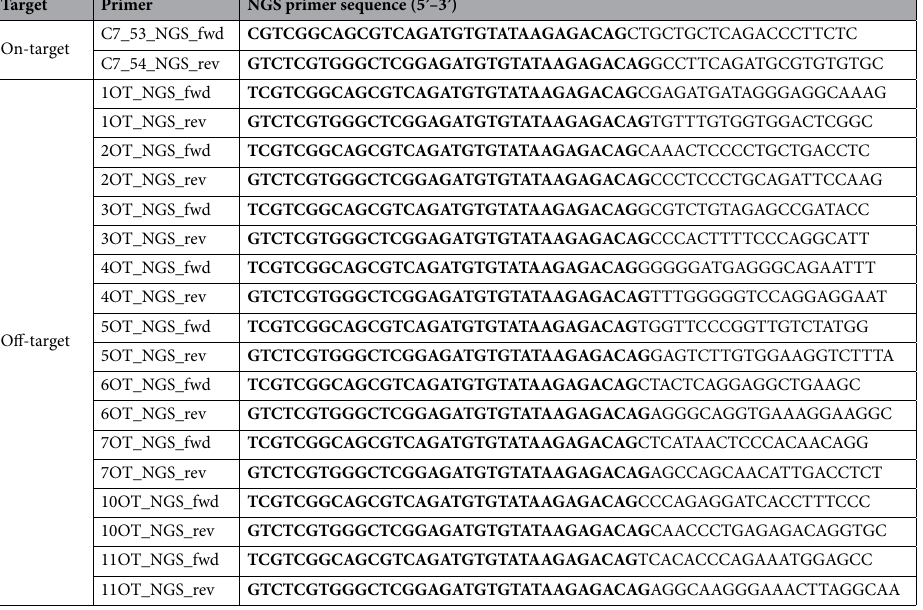
Base editors. ABE7.10 mRNA was obtained from Dr. Anastasia Petrova at the UCL GOS Institute of Child Health. ABE8e was obtained from Dr. David Liu’s lab at the Broad Institute of Harvard and MIT and used in the preliminary base editing experiment to compare the editing efficiency between both ABEs. ABE8e mRNAs included full substitution of uracil for N1-methylpseudouridine, co-transcriptional 5’ capping with the Clean- Cap AG analog resulting in a 5’ Cap1 structure, and included a 120 nucleotide polyA tail. For the follow up gene editing experiments to correct the mutations, ABE8e mRNA synthesised by TriLink was used. Electroporation. The Neon™ Transfection System MPK5000 (Invitrogen) was used to electroporate the fibroblasts with the base editor and sgRNA. The base editing reagents (sgRNA and ABE) for each condition were prepared in a separate well of a 96-well plate and made up to a total volume of 10 μl with TE buffer. 1 × 10 6 Fibroblasts were pelleted (1200 rpm, 5 min), and resuspended in 100 μl Resuspension Buffer R (Neon kit) per condition just before electroporation. 100 μl of the cell suspension was mixed with the base editing reagents, taken up in a 100 μl Neon™ tip ensuring there is no bubble at the top, placed in the pipette holder containing 3 ml of Buffer E2 (Neon kit) and electroporated at Voltage = 1500 V; Width = 20 ms; # pulses = 1 pulse. DNA/RNA isolation. Genomic DNA was isolated using the QIAamp DNA Mini Kit (Qiagen) and RNA was isolated using the RNeasy Kit (Qiagen) according to manufacturer’s protocols. The DNA and RNA were eluted with 40 μl of elution buffer AE and RNase-free water respectively at the end of the extraction process. The concentration and purity of the nucleic acid was measured on a NanoDrop 1000 Spectrophotometer (Thermo Scientific) at the A260/A280 absorbance ratio appropriate for nucleic acids. PCR amplification. The relevant DNA fragment containing the mutations of interest was amplified using polymerase chain reaction (PCR). 50–100 ng of DNA were used as starting material for all PCR amplifications. A PCR master mix was made using AmpliTaq GoldTM 360 DNA polymerase (Applied Biosystems), GC buffer (Applied Biosystems), primers at 10 mM concentration (Invitrogen) and nuclease-free water (Synthego). The following primers used for NGS analysis are listed in Table 1. Sanger sequencing. The PCR products were purified from unincorporated primers and dNTPs using illustraTM ExoProStarTM (Cytiva). The reaction was heated at 37 °C for 30 min, 80 °C for 15 min, and held at 10 °C using the Veriti Thermo cycler. Samples were sequenced externally (SourceBioScience) and the result chromatograms were analyzed using SnapGene viewer. Editing efficiency was analysed using EditR software 20 (http:// basee ditr. com/). NGS genomic DNA on‑target site analysis. The same DNA samples used in the Sanger sequencing method were subjected to high-throughput sequencing (Next-Generation Sequencing, NGS) with sequence- specific primers with NGS overhang, overhang shown in bold in Table 1. All sequencing runs were performed on